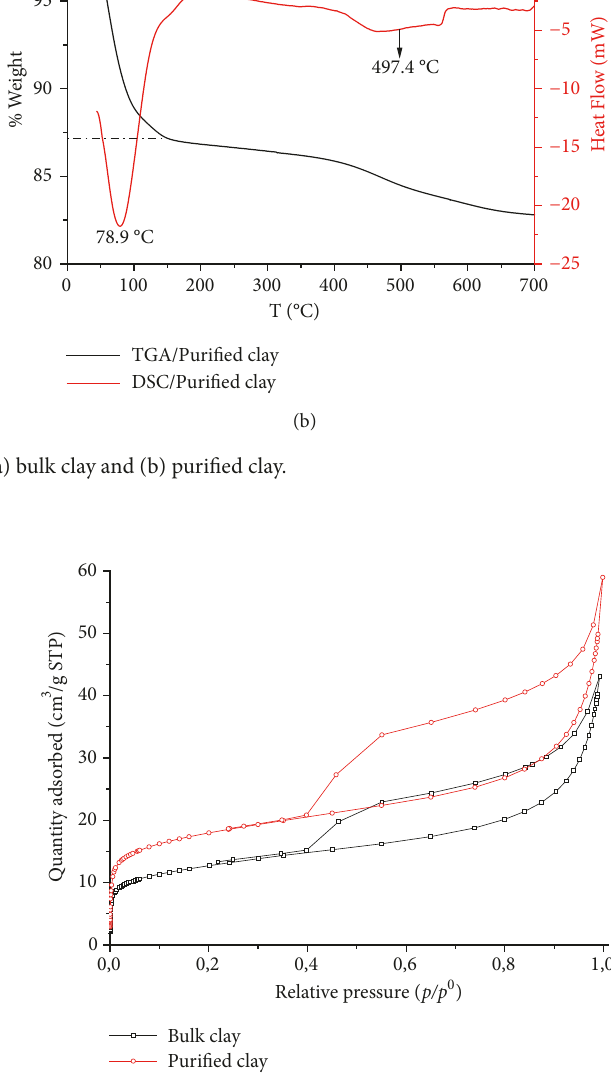
Figure 7: N 2 physisorption isotherm of the bulk and purified